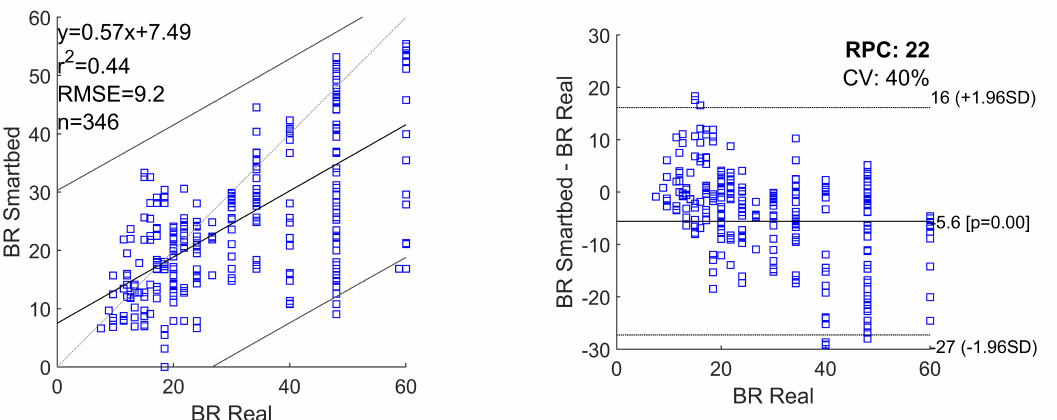
Figure 9. Linear regression plot and Bland–Altman plot of all the analyzed breathing rates of each epochs for the smart bed (BR smart bed) and reference (BR real) signal. The breathing rates are pooled over all the epochs and recordings. In the plots are reported the linear regression equation, squared Pearson r -value (r 2 ), root mean squared error (RMSE), number of analyzed breathing rates (n), reproducibility coefficient (RPC), and the coefficient of variation expressed as a percentage (CV). The lines of mean of difference between BR smart bed and BR real, and the 95% limits of agreement are